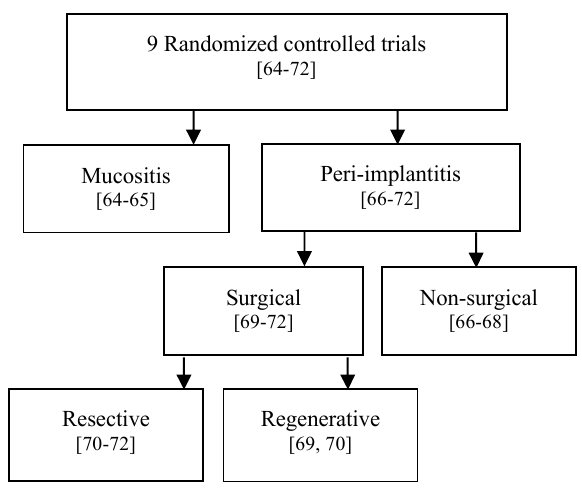
Figure 2. Comparison assessment of the studies according to indication.